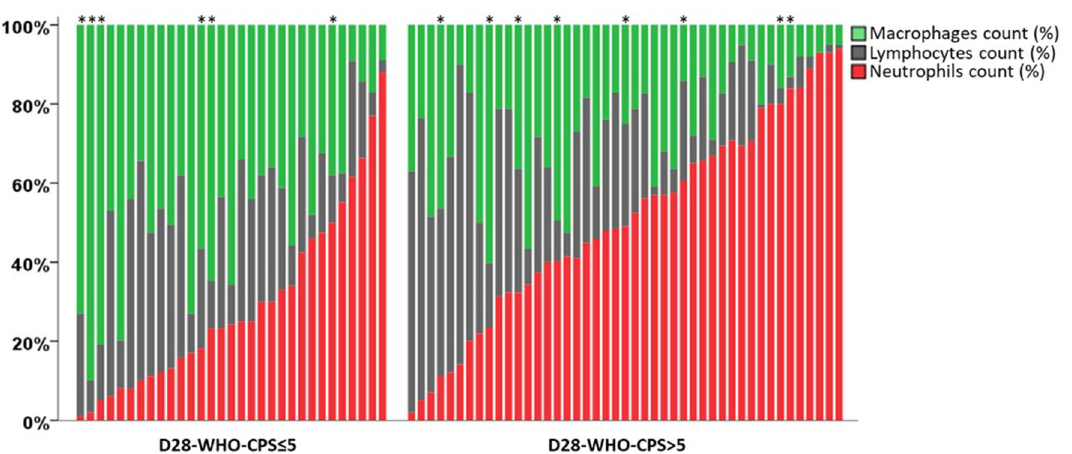
Figure 2. Contributions of main cellular types (macrophages, lymphocytes and neutrophils) in bronchoalveolar lavage fluid in critically ill COVID-19 patients, according to the 28-day WHO-CPS. Stacked bars represent the percentages of macrophages (green), lymphocytes (grey) and neutrophils (red) in bronchoalveolar lavage fluid (BALF). Each vertical line represents data from one single patient. Stars point out patients with a bacterial documentation in BALF. Patients were grouped according to the World Health Organization 10-point Clinical Progression Scale (WHO-CPS) at 28-day. A score value higher than 5 (D28-WHO-CPS > 5) defined a poor 28-day outcome, whereas a score value equal or lower than 5 (D28-WHO-CPS ≤ 5) defined a good 28-day